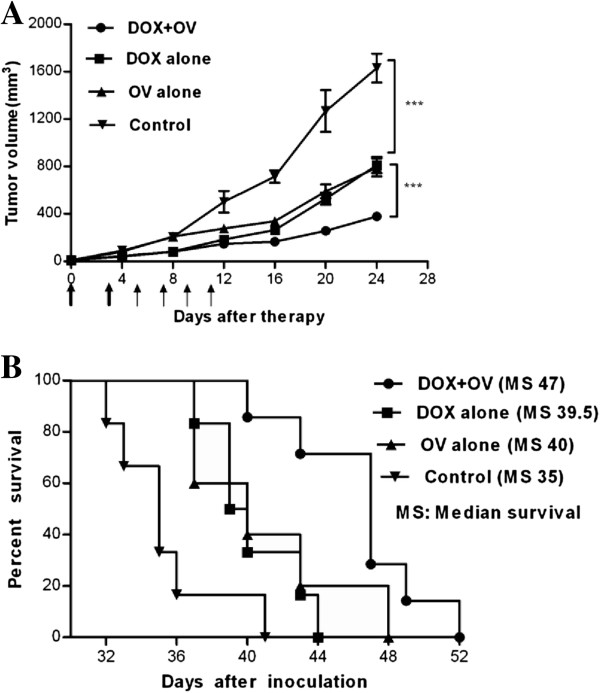
Anticancer effect of doxorubicin and/or HSV1-hGM-CSF against 4T1 breast tumors. The mice bearing 4T1 tumors were treated with doxorubicin and/or HSV1-hGM-CSF as described in the Methods section. (A) The tumor volume of mice among the different groups was measured every 4 days following treatments. The data represent the mean ± SEM (n=6). Arrows indicate the type of treatments: thick arrows for doxorubicin chemotherapy and thin arrows for oncolytic HSV1-hGM-CSF treatment. (B) The median survival times for the 4 groups are illustrated in Kaplan–Meier survival curves (n=5-7). ***, p < 0.001. The experiment was performed twice with similar findings. Abbreviations: DOX, doxorubicin; OV, HSV1-hGM-CSF.